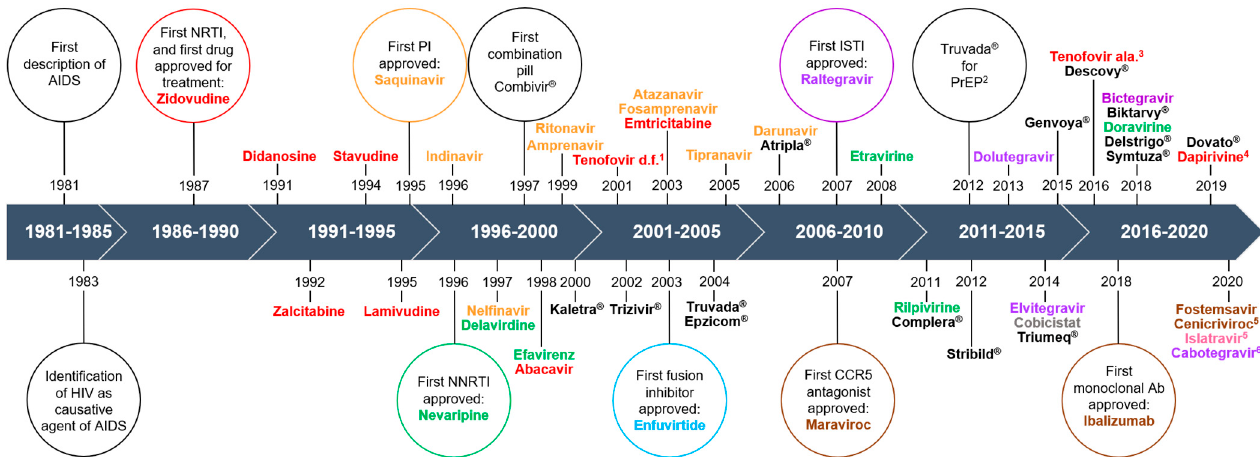
Figure 1. Timeline of antiretroviral drug development. Major milestones are encircled. Individual drugs are shown with the year the United States Food and Drug Administration granted approval for use. Individual drug names are colored coded by drug class: red = nucleoside reverse transcriptase inhibitor (NRTI); orange = protease Inhibitor (PI); green = non-nucleoside reverse transcriptase inhibitor (NNRTI); blue = fusion inhibitor; purple = integrase strand transfer inhibitor (ISTI); brown = entry inhibitor. Islatravir, in pink, is the first nucleoside reverse transcriptase translocation inhibitor (NRTTI). Cobicistat, in gray, is an analogue of ritonavir, and the first antiretroviral booster that does not have antiviral activity. Registered brand names, in black, are used for combination pills for space considerations. 1 tenofovir disoproxil fumarate; 2 PrEP = pre-exposure prophylaxis; 3 tenofovir alafenamide; 4 FDA approval pending for vaginal ring formulation; 5 currently in phase III trials; 6 approved in early 2021 as a long-acting injectable, the first of its kind. It is co-administered with a long-acting formulation of rilpivirine.